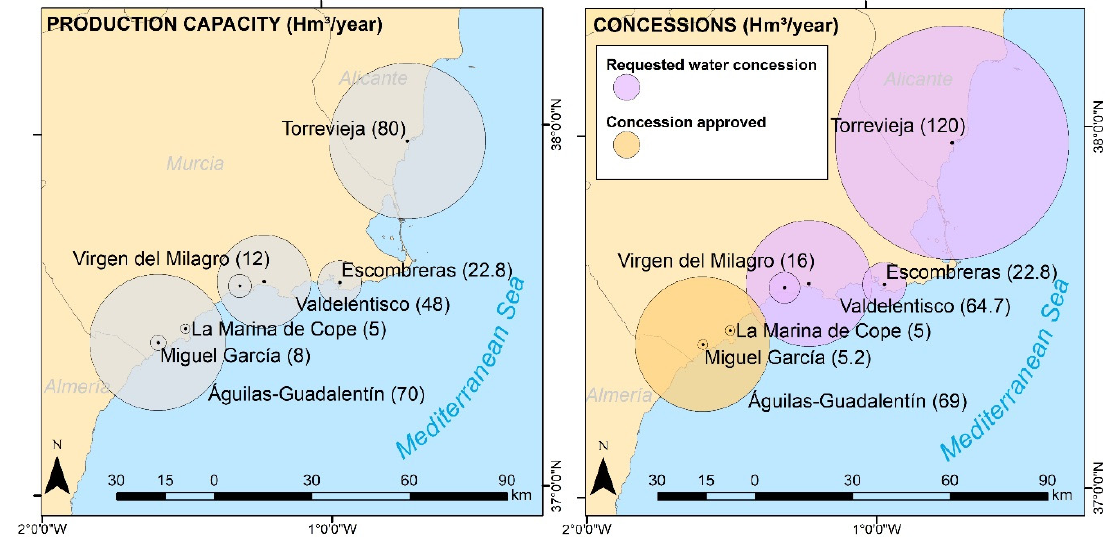
Figure 3. Production capacity of the desalination plants and concessions approved and in process in the SRB for irrigation uses. Source: own elaboration from ACUAMED and SRB data.